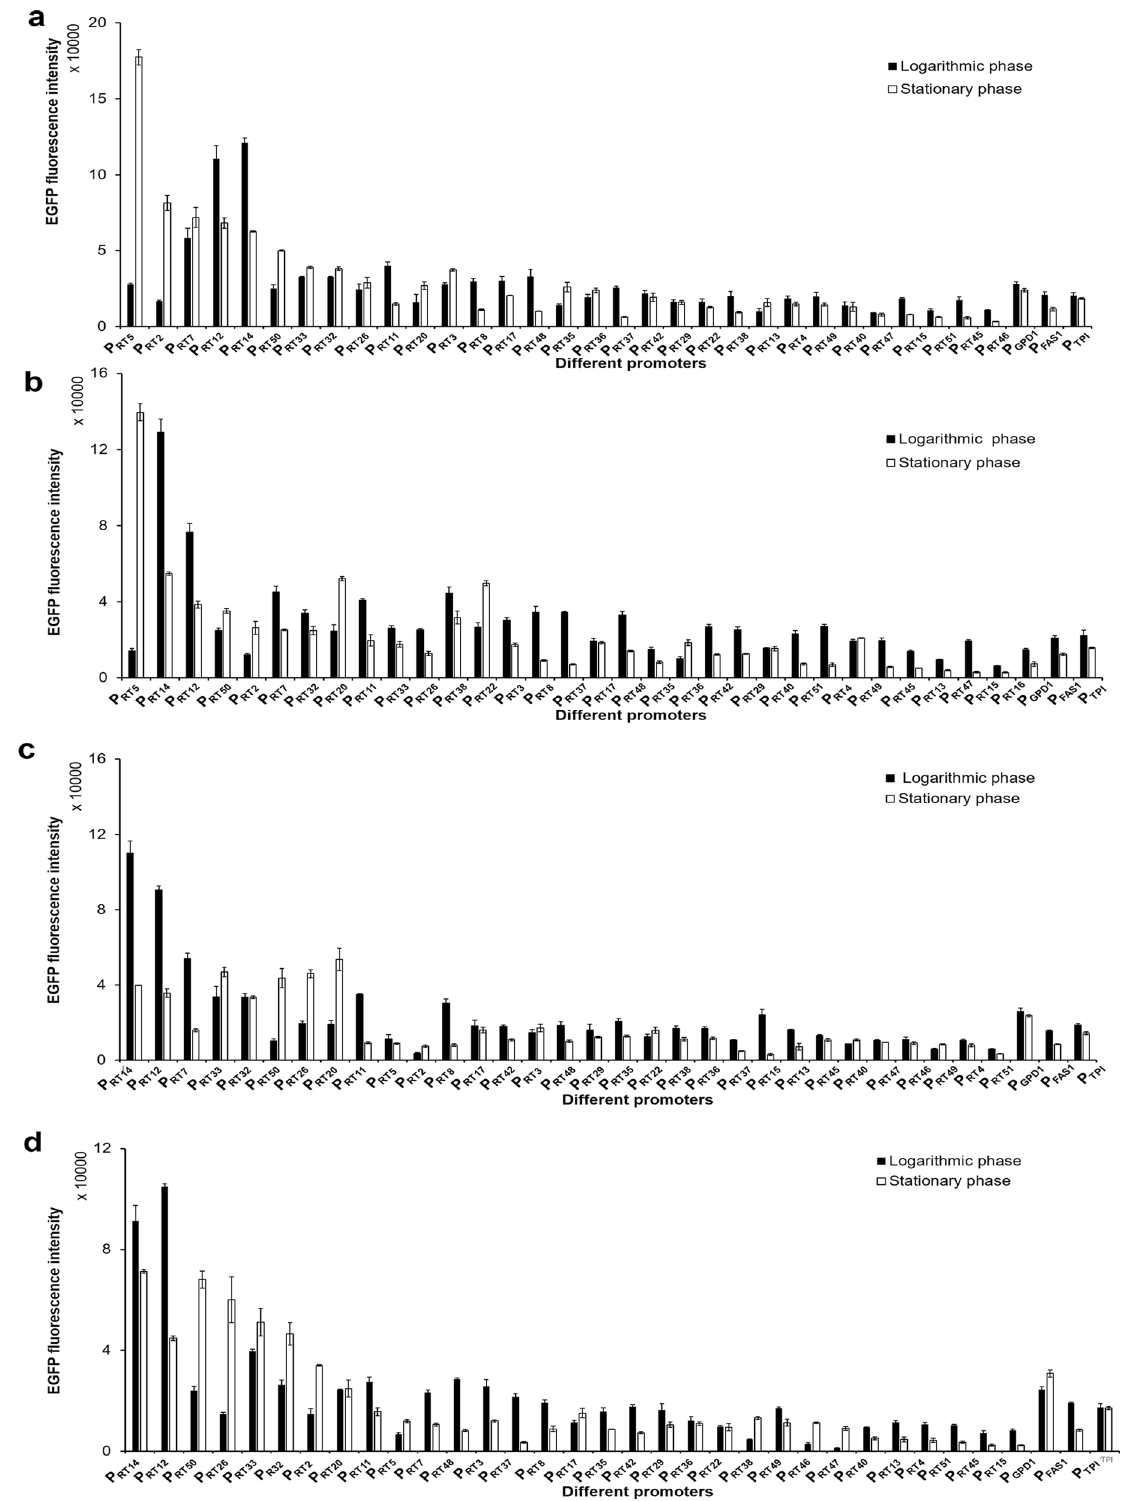
Fig. 1 EGFP fluorescence intensities expressed by different promoters in four types of media under different growth phases. a YPD medium; b YPX medium; c SC medium; d MM medium. Solid columns represent the logarithmic growth phase and hollow columns represent the stationary phase. The corresponding sampling time for logarithmic and stationary growth phase is: 23 h and 48 h for YPD, 26 h and 60 h for YPX, 26 h and 48 h for SC, 20 h and 48 h for MM medium, respectively. Data were derived from